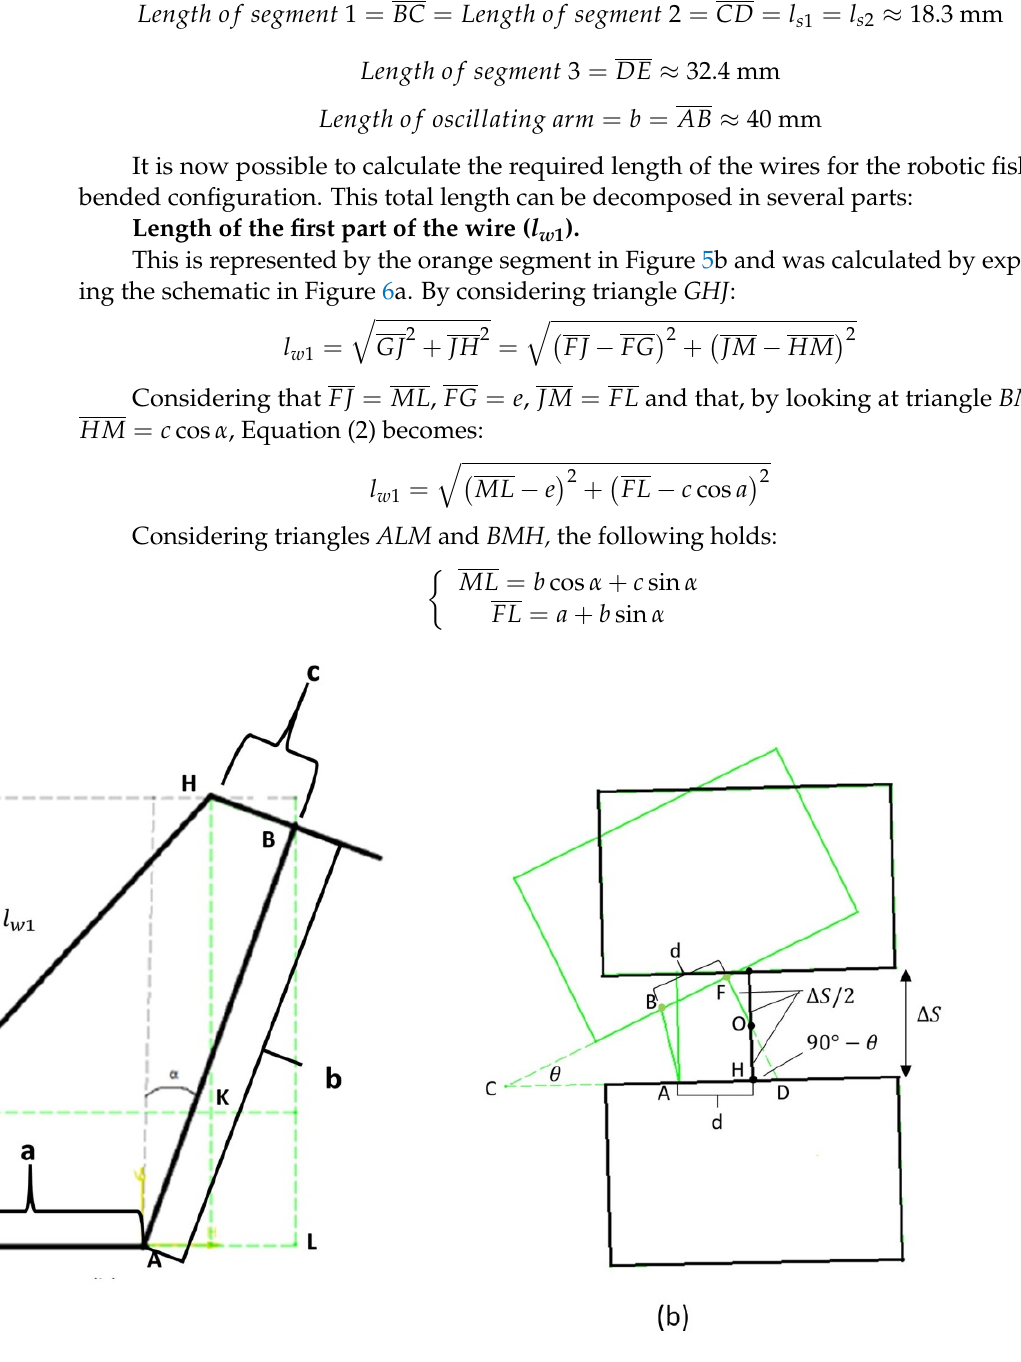
Figure 6. ( a ) Schematic to calculate the length of the first part of wire l w 1 . b represents the length of the connecting plastic rod and α the maximal bending angle equal to 26 ◦ ( b ) Schematic of relative position of two consecutive segments when the fish body is in straight configuration (black) and in maximal bending configuration (green).